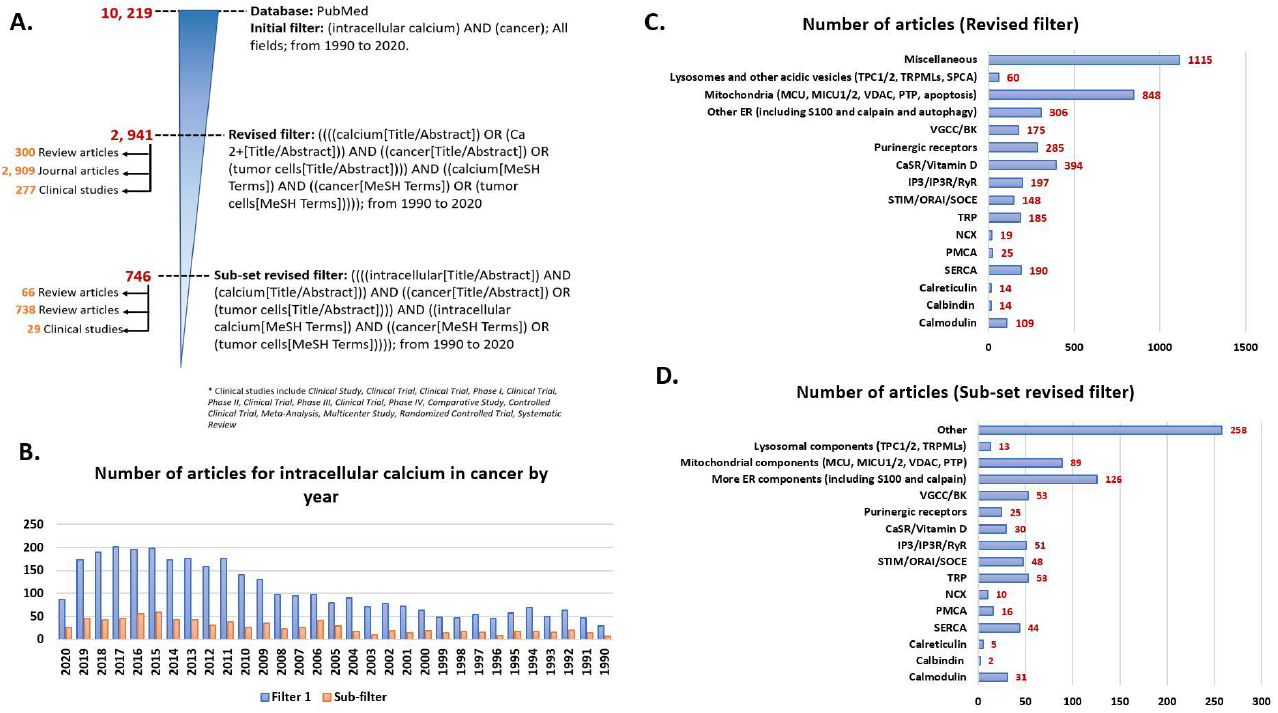
Figure 10. Trends observed in published articles on the role of intracellular Ca 2+ in cancer. ( A ) Schematic of finding articles published from 1990 to 2020 on intracellular Ca 2+ in cancer. The number of articles published based on each advanced search filter combination is indicated in red. All the articles found with revised filter and subset-revised filter are further broken down into review articles, journal articles, and clinical studies. ( B ) Year-based distribution of the total number of published articles on intracellular Ca 2+ in cancer differentiated per the search filters. The yearly distribution of the number of published articles identified using subset-revised filter is uniformly correlated with that of the revised filter; ( C ) Categorization of the number of published articles found using the revised filter per the main intracellular Ca 2+ signaling molecule(s) in each study. ( D ) Categorization of the number of published articles found using the sub-set revised filter per the main intracellular Ca 2+ signaling molecule(s) in each study. The articles were sorted by using the categories listed on the y-axis in panels ( C , D ) as keywords to be identified in the list of articles (title, abstract, and MeSH words) extracted with Revised Filter 1 by creating a dynamic search feature in Excel.